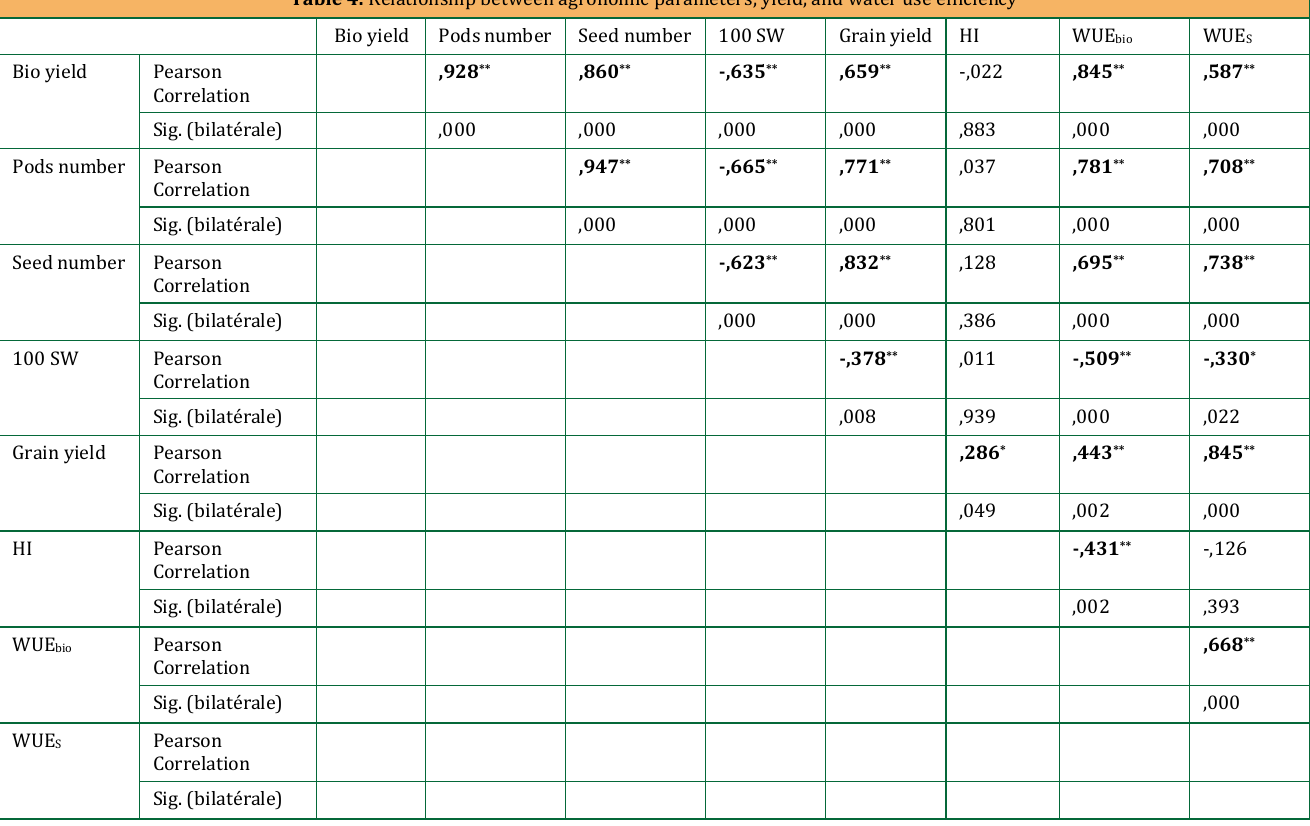
Figure 8: Mean values of biological water use efficiency as a function of Figure 9: Mean values of seeds water use efficiency as a function of the the interaction’s cultivar × bioclimatic stage interaction’s cultivar × bioclimatic stage Table 4: Relationship between agronomic parameters, yield, and water use